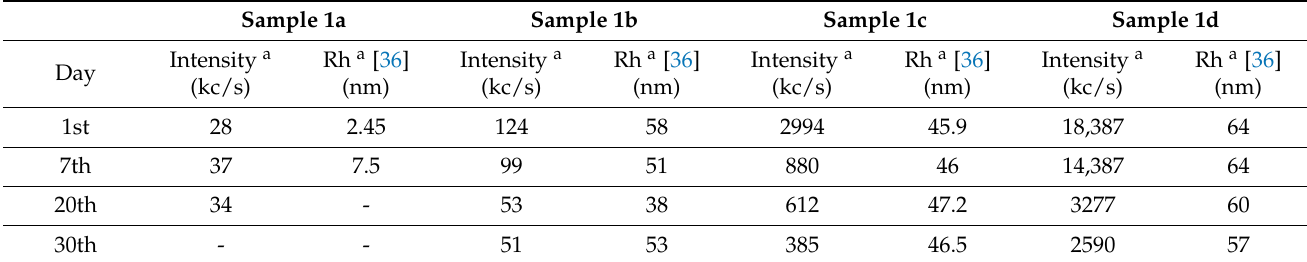
Table 2. Intensity and R h values of samples 1a, 1b, 1c, 1d on 1st day, and after 7, 20, 30 days.